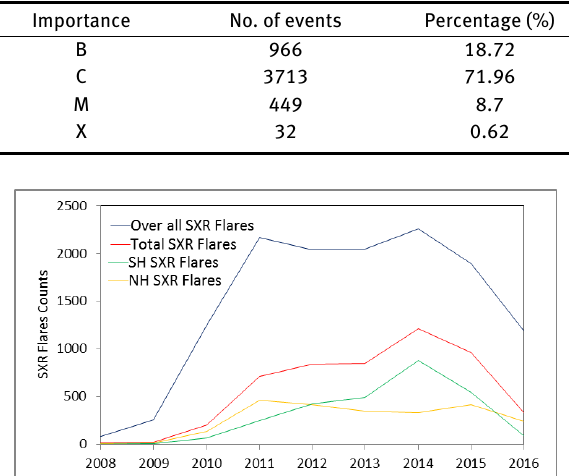
Table 1. The Number and percentage of SXR flares for different importance class. Here percentage (%) expresses fraction of 5160 number of total SXR flares.